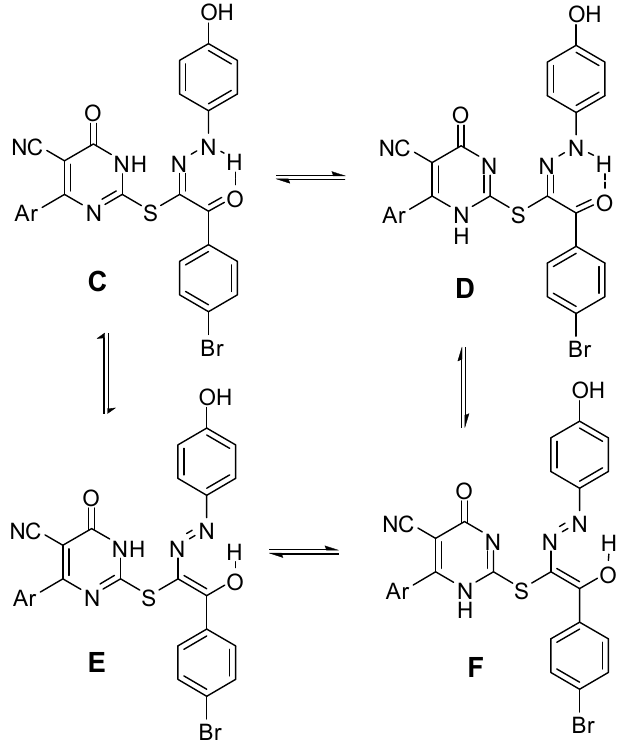
Figure 3. Possible tautomeric structures of compounds 7a – c